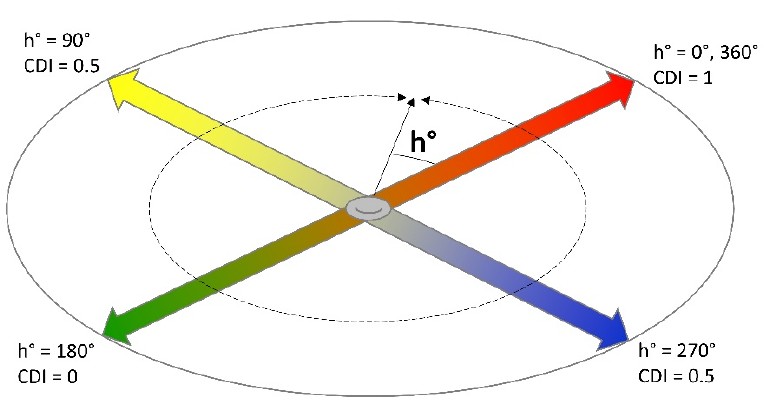
Figure 1. CieLAB colour space and representation of hue angle (h ◦ ) and Colour Development Index (CDI) values around the colour wheel (adapted with permission from Scalisi et al. [8]).